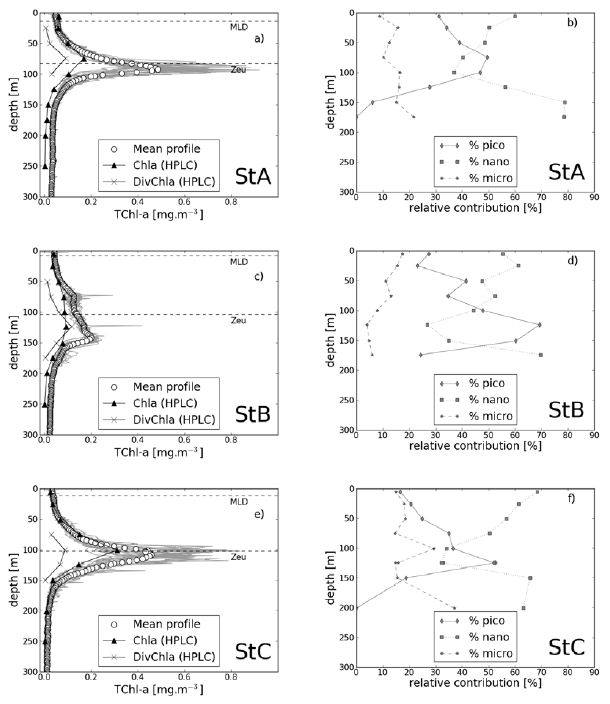
Fig. 2. Vertical profiles of calibrated fluorescence performed during Figure 2. the whole time period of sampling at the long duration stations A (a) , B (c) , and C (e) , together with the discrete measurements of chlorophyll- a and divinyl chlorophyll- a performed by HPLC (see text). Vertical profiles of the relative proportion of pico-, nano- and microphytoplankton at the long duration stations A (b) , B (d) , and C (f) . The depth of the euphotic zone, Zeu, and the lower limit of the mixed layer, MLD, are